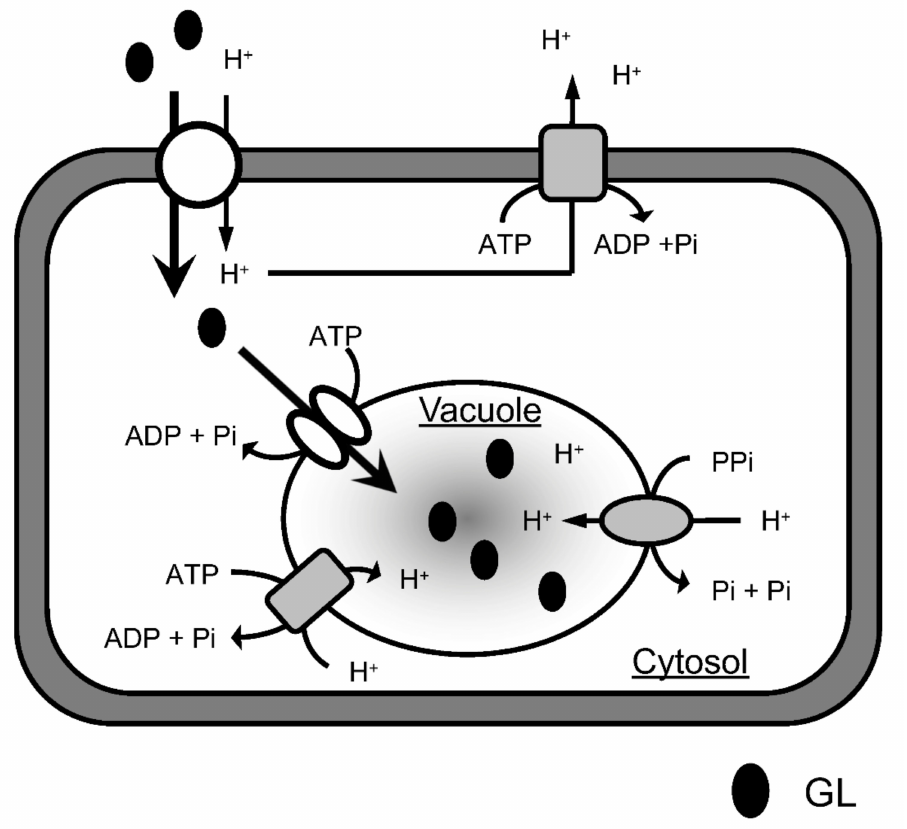
Figure 10. A proposed model for GL transport and accumulation. The H + /GL symporter slowly transports exogenous GL into the cytosol via a proton gradient formed by P-ATPase, while GL is rapidly taken up from the cytosol into the vacuole by the ABC